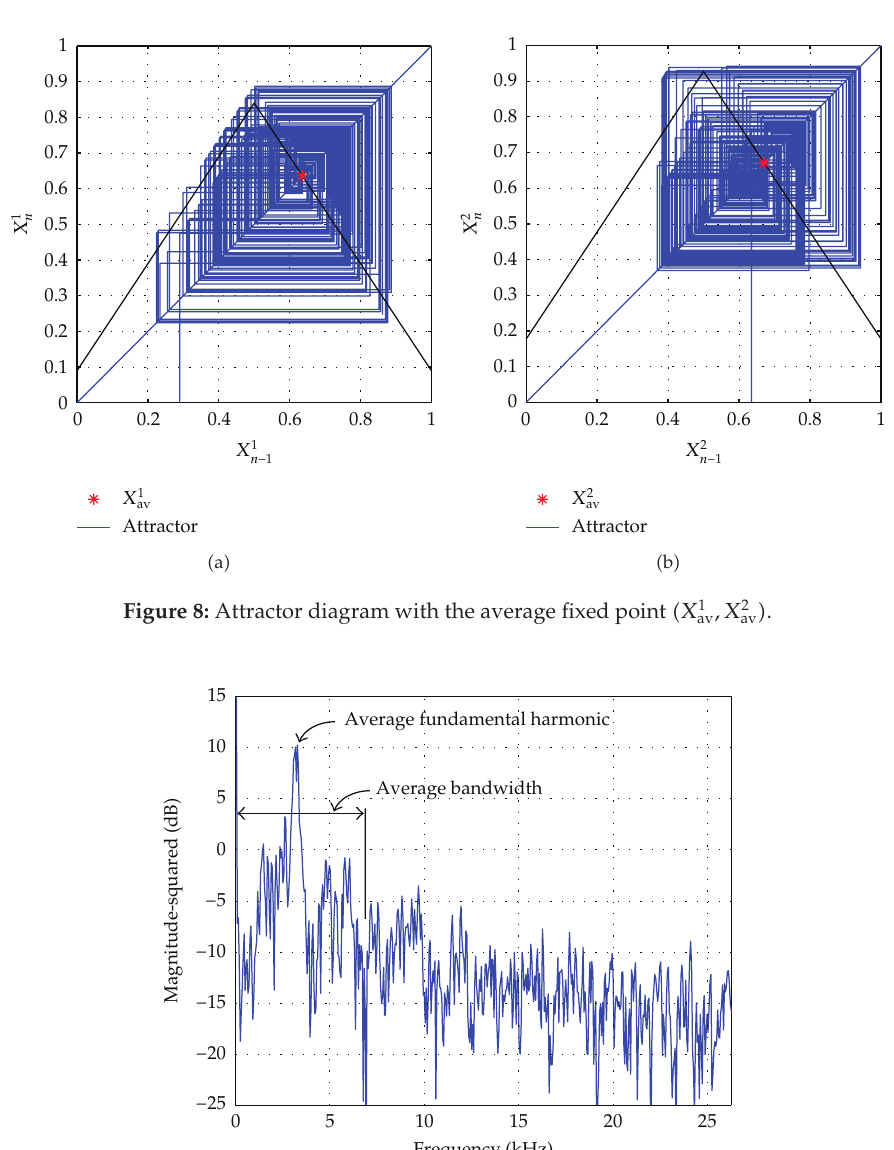
Figure 9: Average spectrum of the CPWPM